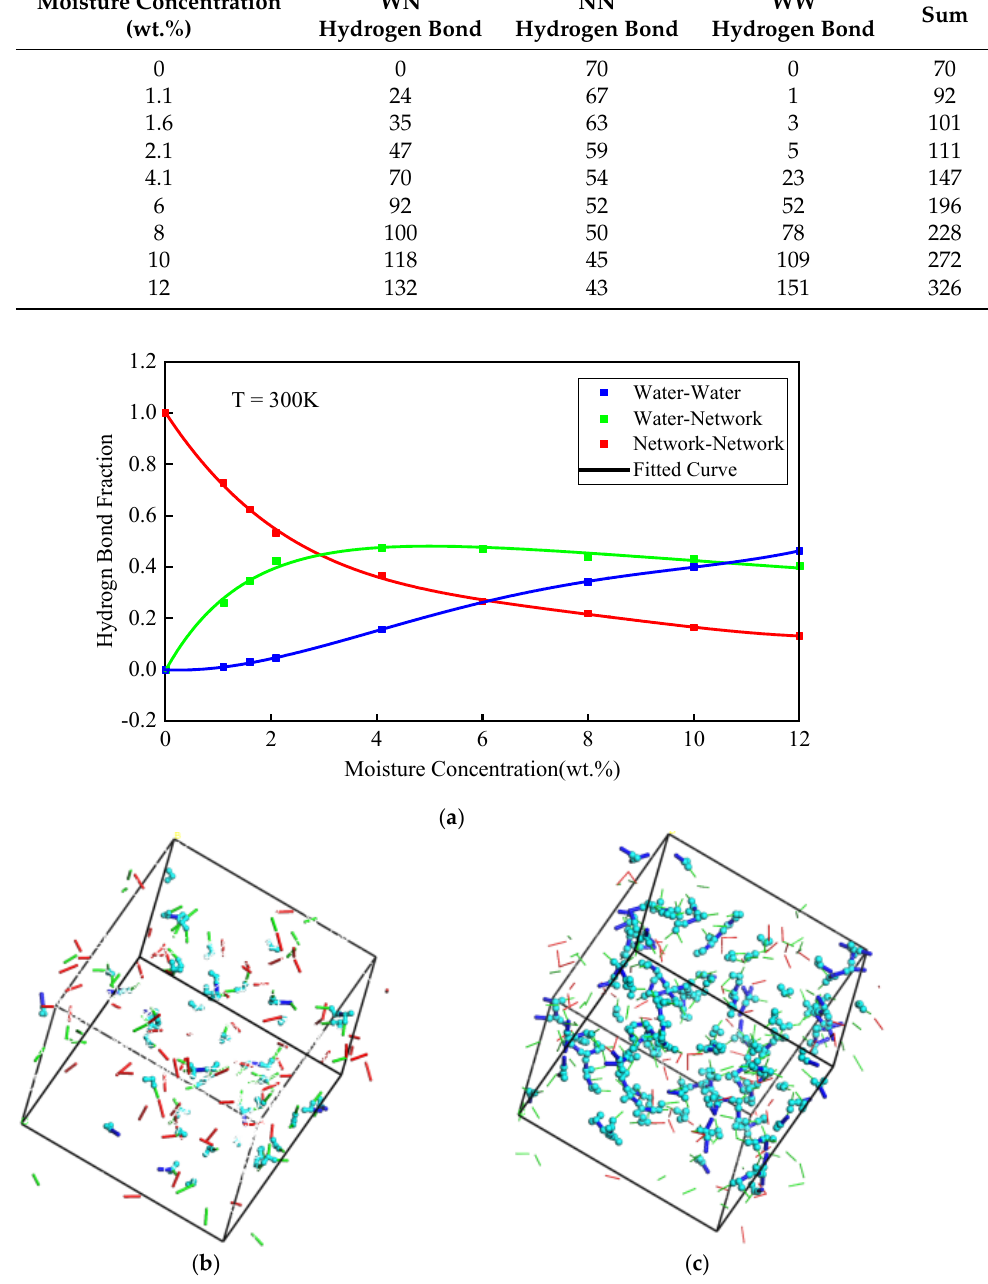
Figure 7. ( a ) Ratio of hydrogen bonds with different pairs of donor and acceptor for various moisture concentrations. Hydrogen bond at moisture concentration of ( b ) 4.1 wt.% and ( c ) 12 wt.%. The red lines are NN hydrogen bonds. The green lines are WN hydrogen bonds. The blue lines are WW hydrogen bonds. The light blue balls are water molecules. Table 1. Number of hydrogen bonds in the system at different moisture concentrations.